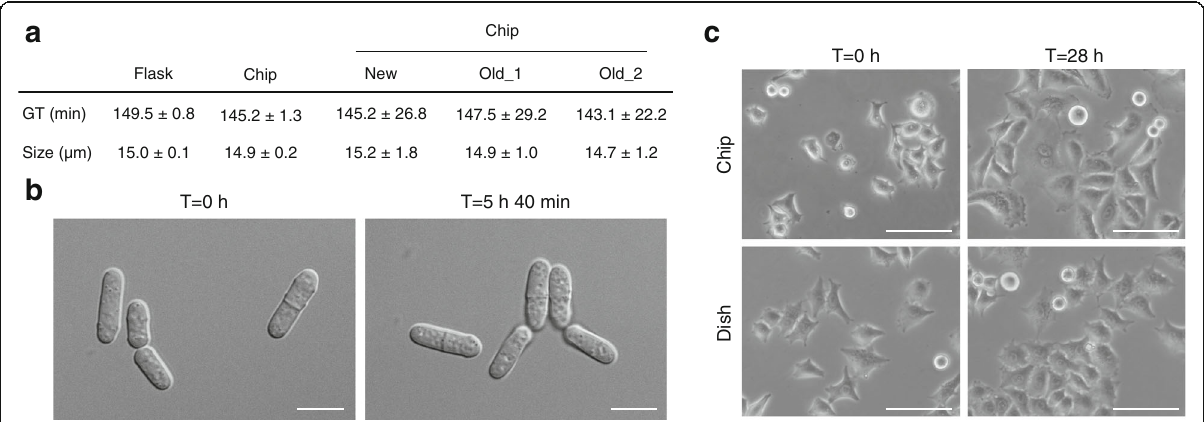
Fig. 4 Biocompatibility of the elastomer microfluidic chips. a , b . All experiments used chips as in Additional file 4C. a. Fission yeast cells were injected in a lectin-coated microchip, and medium was perfused (20 μ L/min) at 32 °C. After 2 h, images were acquired over > 5 h to calculate generation times and cell sizes at division. Results from a newly cut elastomer chip were compared to those obtained with re-used chips (> 10 times) and in control batch cultures. For each parameter in the first two columns (flask and chip), the average of 3 independent experiments is shown with the standard error. Size at division: n ≥ 50. Generation time in chips: n > 20. Data for individual chips (last three columns) are shown with their standard deviations. Old: re-used chips. b. DIC images of cells grown in the chips in a at the indicated times. Scale bars = 10 μ m. c. HeLa cells were injected in a chip or in a standard culture dish at similar densities and grown for 28 h at 37 °C. A constant flow of medium (5 μ L/ min) was applied in the chip after cells were allowed to adhere to the glass (~ 3 h after injection, T = 0). At T = 0, 5.4 and 8.2% of cells were in mitosis (rounded or in duplets prior to cytokinesis) in flask and in chip, respectively ( n ≥ 100). At T = 28 h, 2.8 and 7.5% of cells were in mitosis in flask and in chip, respectively ( n ≥ 100). The chip used the perfusion channel as in Additional file 4C but no temperature channel (see Methods): to simplify this proof-of-concept assay, sample temperature was maintained by a high precision hot plate. For this, chip and tubings were pre- incubated overnight with 2 mg/mL BSA at 4 °C and washed with medium prior to cell injection. Bright-field images. Scale bars = 100 μ